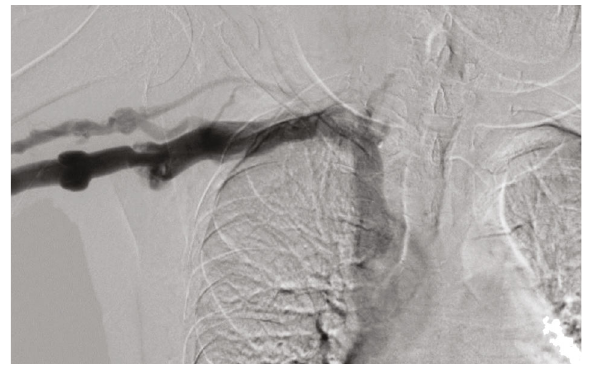
Figure 8: Basilic vein